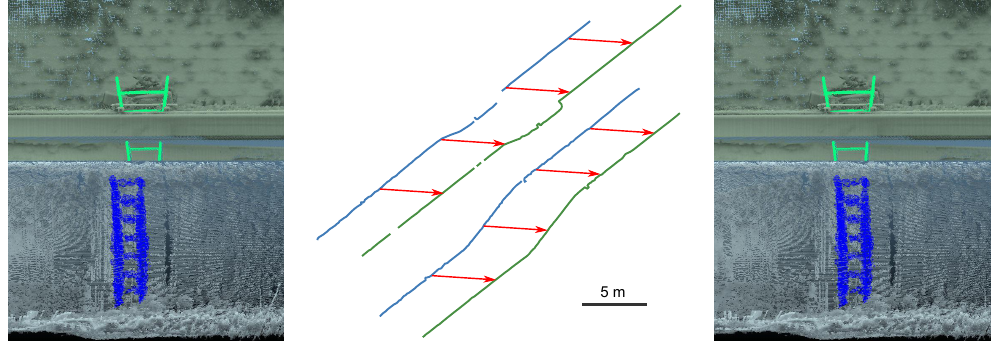
Figure 19. ( Left ) Correction of the vertical translation; ( Center ) Silhouette of the waterline in the TLS and MSS models; ( Right ) Correction of the horizontal translation (final